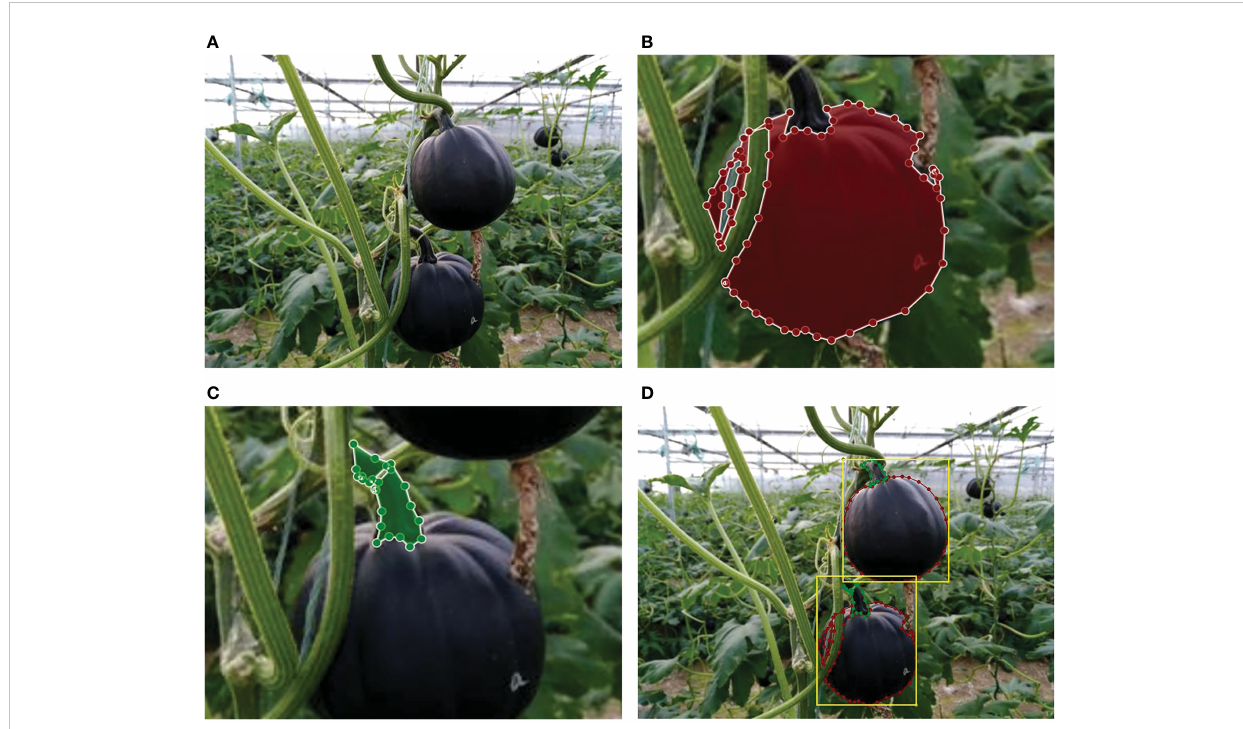
FIGURE 3 Illustration of the image annotation process. (A) Original image. (B) Polygonal annotation and extraction of the pumpkin fruit mask. (C) Polygonal annotation and extraction of the pumpkin stem mask. (D) Annotated images, red polygons are pumpkin fruits, green polygons are pumpkin stems, yellow boxes are